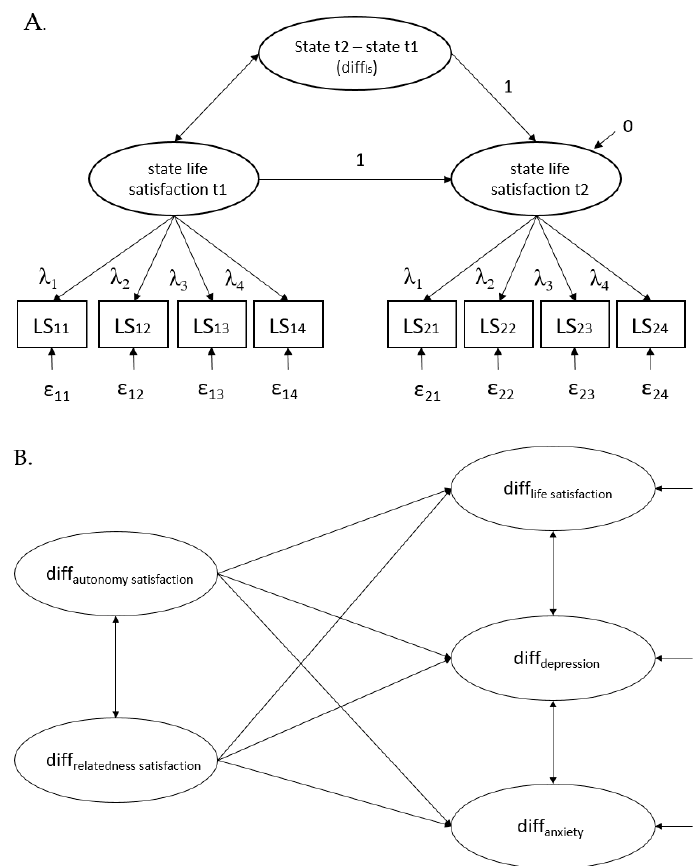
Figure 1. ( A ) Example of the Measurement Model Part of the Latent Change Model for Life Satisfaction ( B ) Structural Part of the Latent Change Model; standardized coefficients are reported. t1 = before the lockdown, t2 = today, LS ij = life satisfaction observed indicator no. i at time point j (1 = before lockdown, 2 = now). ε ij = residual of item no. i at time point j, λ i = time-invariant factor loading of observed indicator i, regression coefficients of the latent difference variable (diff ls ) and state life satisfaction at t1 were fixed at 1, the residual variance of state life satisfaction at t2 was fixed at 0.